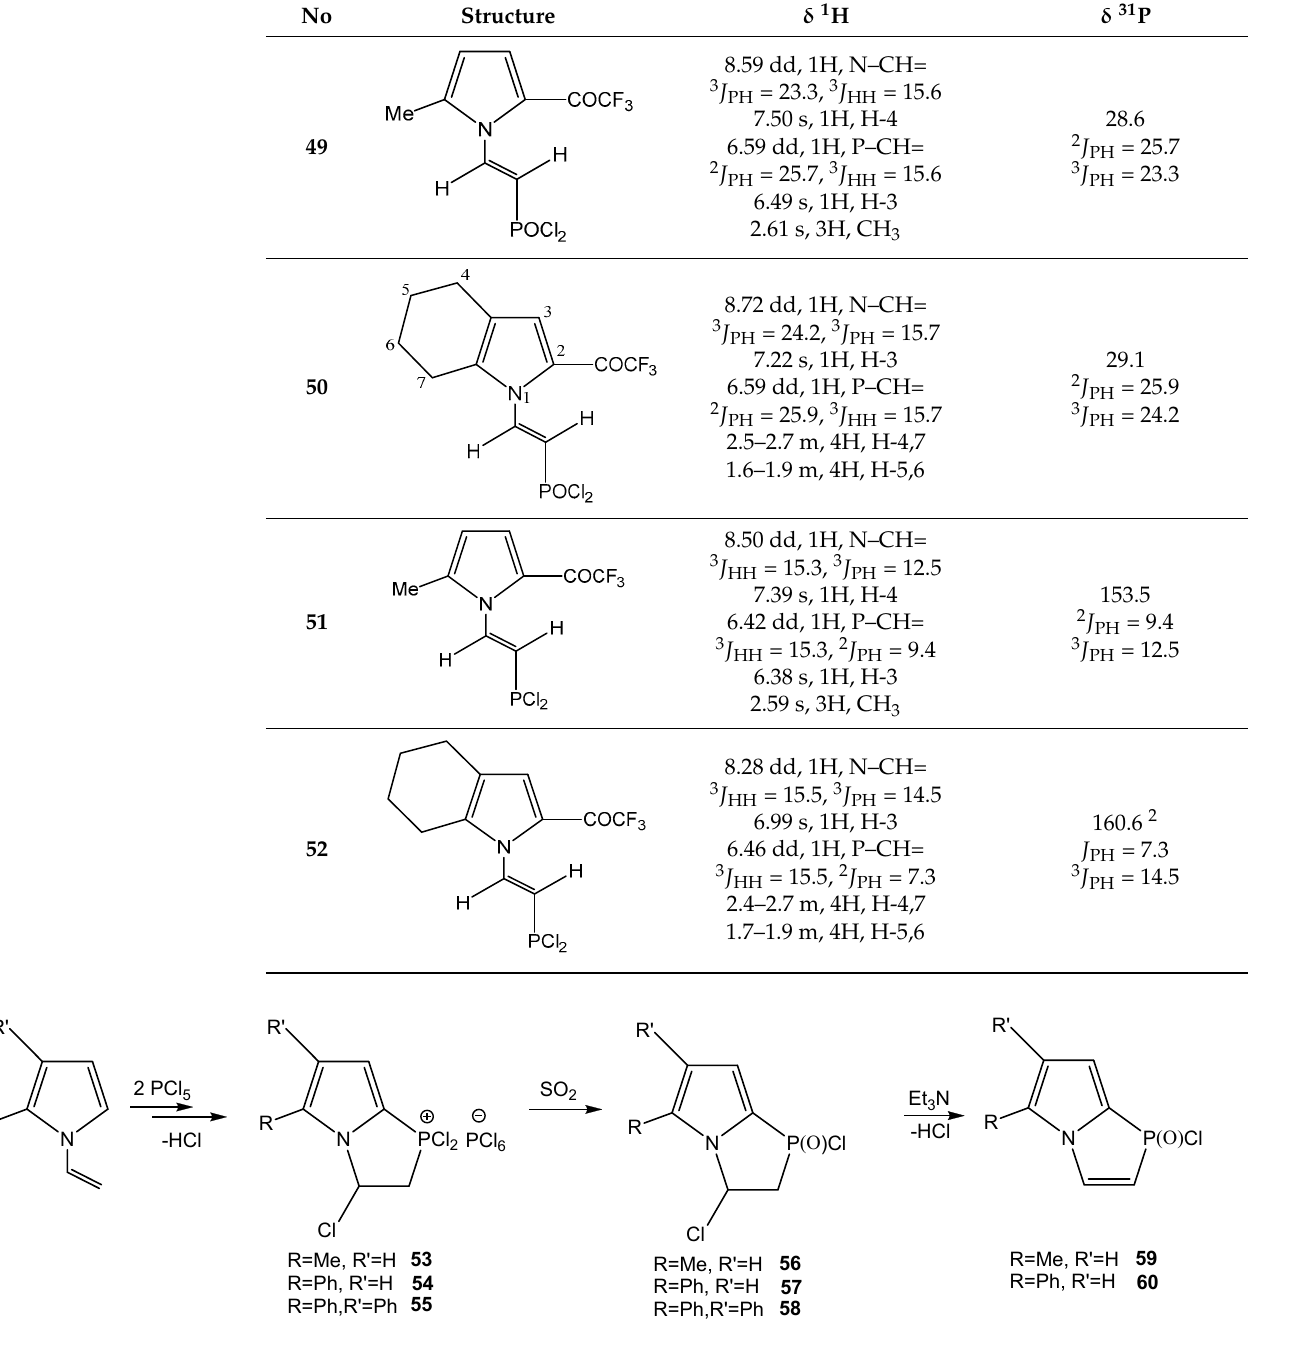
Scheme 13. The phosphorylation of 1-vinylpyrroles. Table 17. 1 H, and 31 P NMR chemical shifts ( δ , ppm) and coupling constants ( J , Hz) of phosphory- lated pyrroles 56 , 57 (CDCl 3 ).